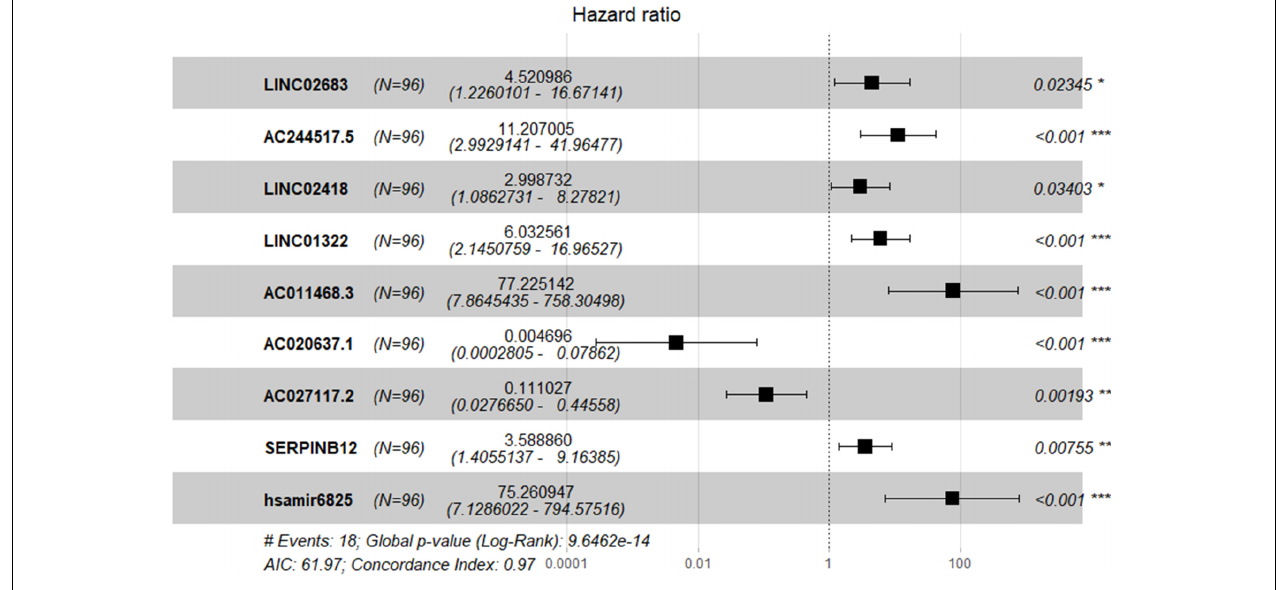
Based on the results of the multivariate Cox stepwise regression model and median risk score point, the patients in the training cohort could be divided into “high risk” and “low risk,”